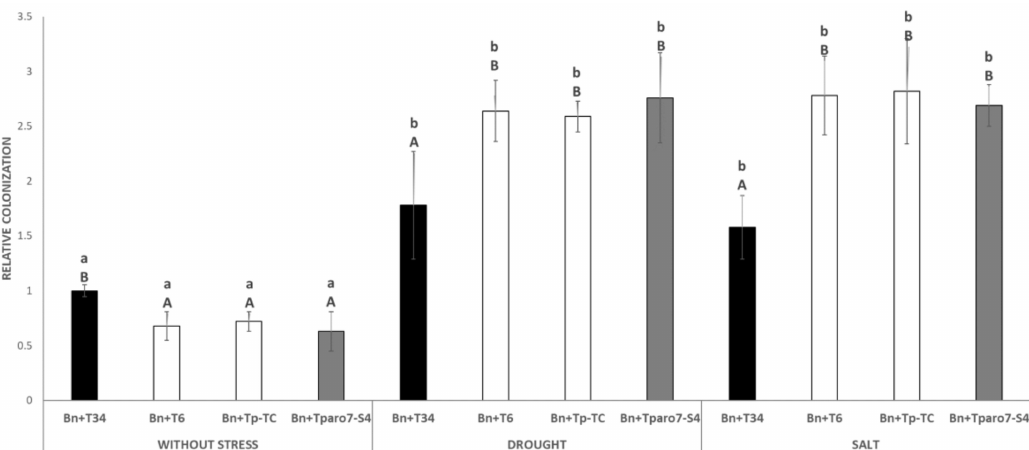
Figure 2. Measurements of rapeseed-root colonization by T. harzianum ( + T34), T. parareesei ( + T6), T. parareesei transformation control ( + Tp-TC), and the transformant with the silenced Tparo7 gene ( + Tparo7-S4) without stress, under drought stress and under salt stress (NaCl 200mM). To quantify rapeseed root colonization, the DNA of the fungus was quantified by qPCR from radicular samples using the actin genes from both the plants and the fungus. Fungal DNA / plant DNA ratio was normalized to 1 in the case of T34 and was calculated based on this data for the rest of the situations and inoculants. Data are the mean of three biological replicates for each condition with the corresponding standard deviation, and for each biological replicate and condition, roots from five plants were used. One-way analysis of variance (ANOVA) was performed, followed by the Tukey’s test. Di ff erent letters represent significant di ff erences ( p < 0.05), comparing between environment within each treatment (strain)- and control-(identify by small letters) and treatment- and control- (strain) within each specific environment (identify by capital letters). Also, two-way analysis of variance (ANOVA) was performed, shown in Supplementary Table S1.